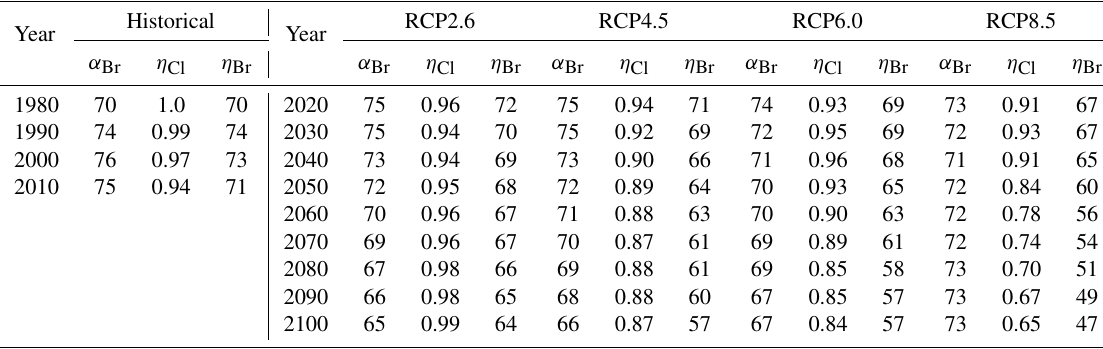
Figure 2. Surface mixing ratios of (a) CO 2 , (b) CH 4 , and (c) N 2 O as a function of time and RCP scenario. Data obtained from Meinshausen et al. (2011). Table 2. Values of extrapolar (60 ◦ S–60 ◦ N) α Bra , η Clb , and η Brb for historical and future